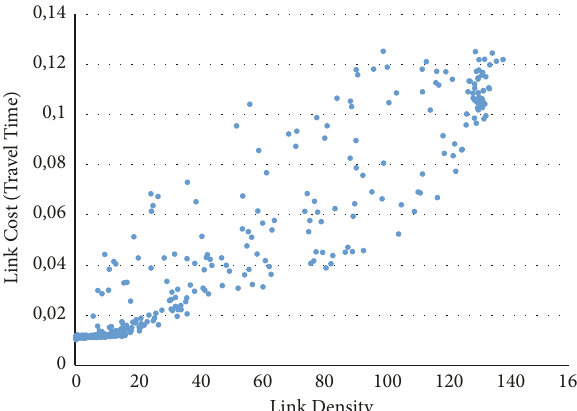
Figure 12: Microsimulation of Cost-Density Relationship.